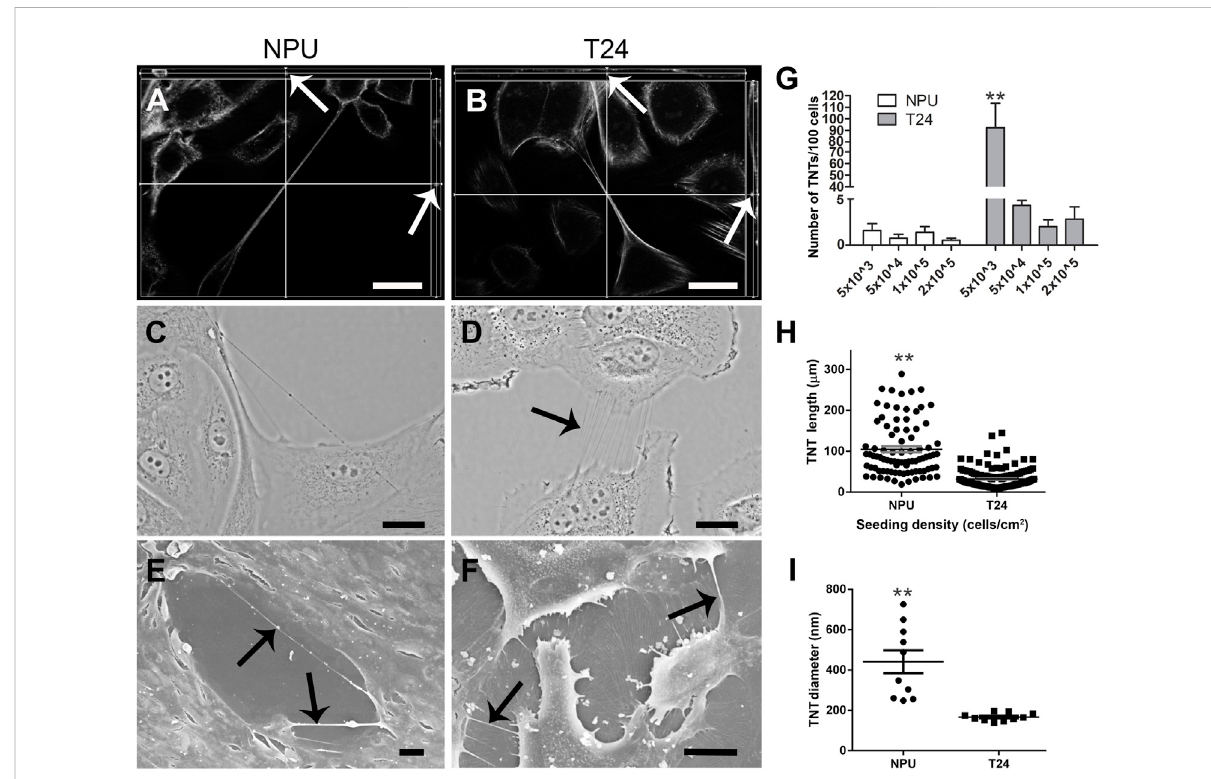
FIGURE 1 TNTs of normal (NPU) and cancer (T24) urothelial cells are morphologically different. TNTs in monocultures of NPU (A) and T24 (B) cells under fl uorescence microscope (C and D) phase-contrast microscope, and under (E and F) scanning electron microscope. TNTs labelled with falloidin- FITC(gray), hoverfreelyinthecultureofNPU (A) andT24 (B) cellsshown onorthoviewsofoptical sections (whitearrows). Scale bars:20 μ m (G) The number of TNTs/100 cells at four seeding densities of both cell types. Numerus of TNTs counted inT24 cells was 1,456, and numerous of TNTs countedinNPUcellswas276,allinthreeindependentexperiments. (H) TNTlengthsweremeasuredfromimagesoflivecellsacquiredwithaphase- contrast microscope. (I) The diameter of TNTs (n = 10 for each cell type) was measured from images acquired with a scanning electron microscope. Only TNTs ≥ 10 μ m were considered for the measurements. The values in all graphs are presented as mean ± SEM. * p < 0.05; ** p <